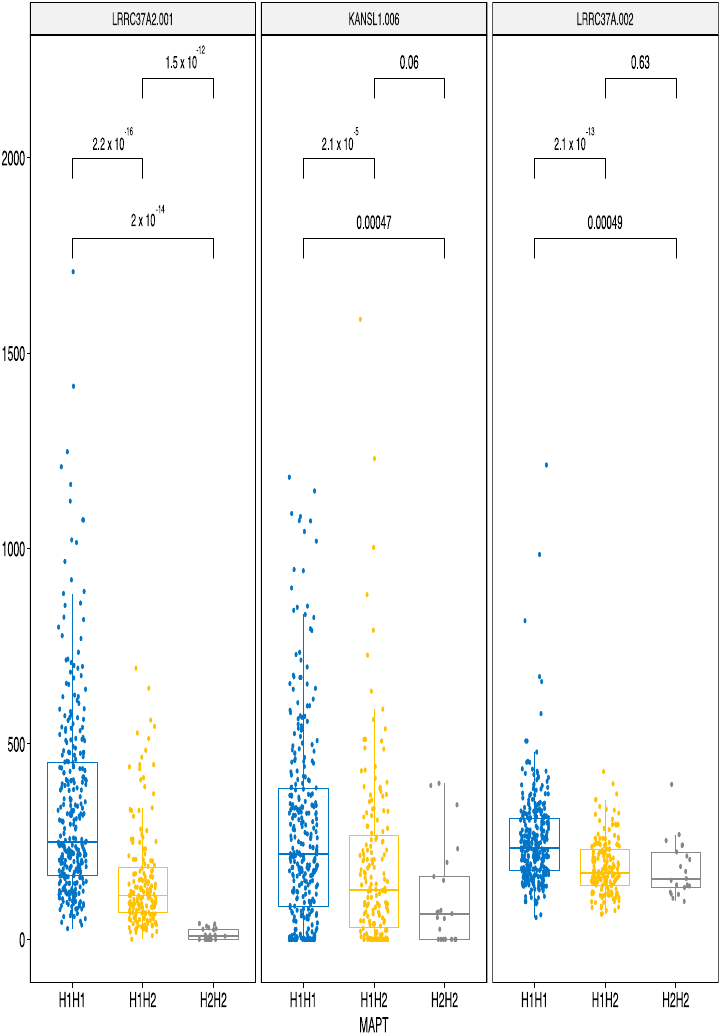
Figure 6. MAPT H2H2 haplotype downregulates several transcripts. LRRC37A2, KANLS1 and LRRC37A transcripts had the highest negative β values (down-regulating effect) and are illustrated here. These are different transcripts from the same genes that are shown in Figure 5 and were up-regulated by the same haplotype. Even a single H2 variant is sufficient to downregulate the expression of given transcripts. The bars indicate pairwise comparisons and respective p -values after the Wilcoxon test.